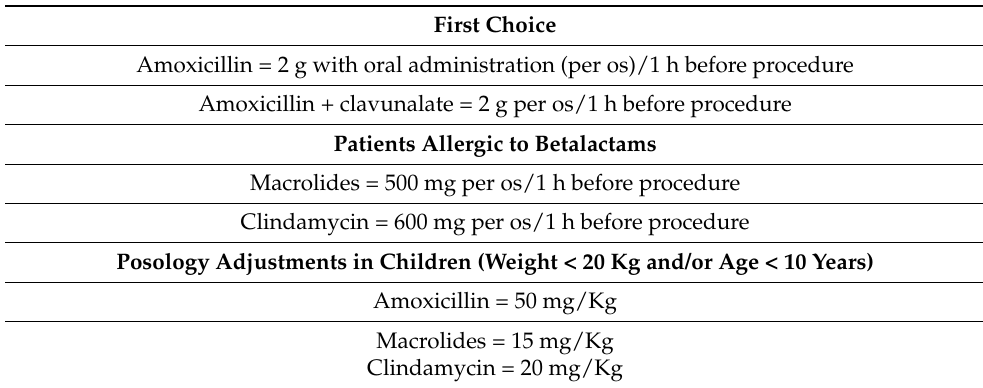
Table 2. Short preoperative antibiotic prophylaxis